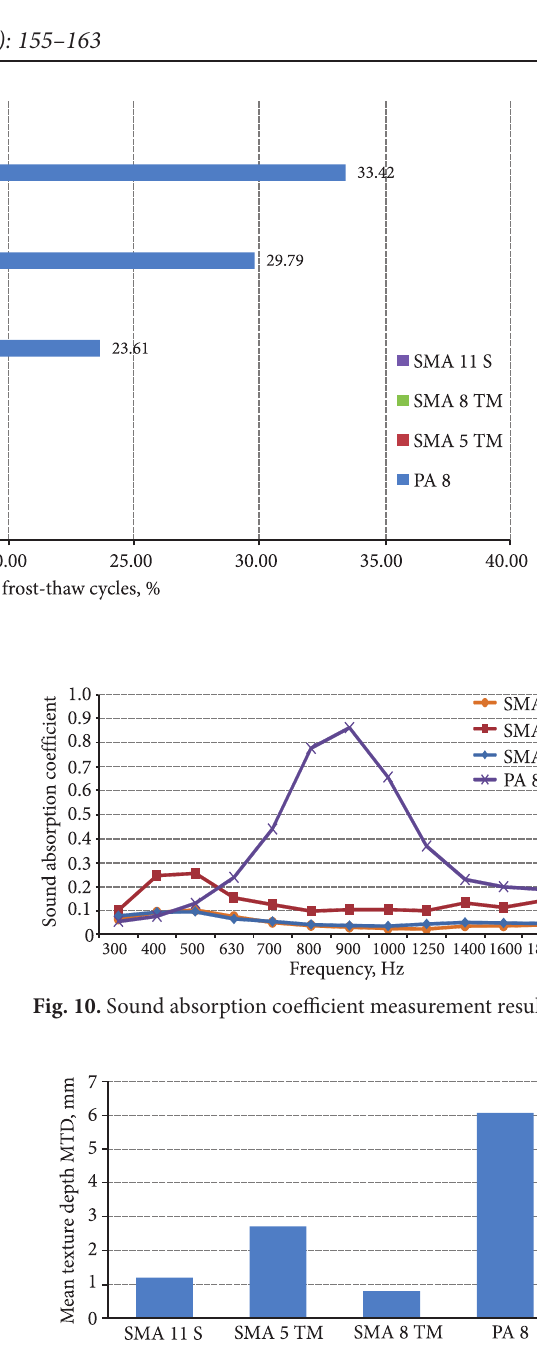
Fig. 11. Mean Texture Depth (MTD) measurement